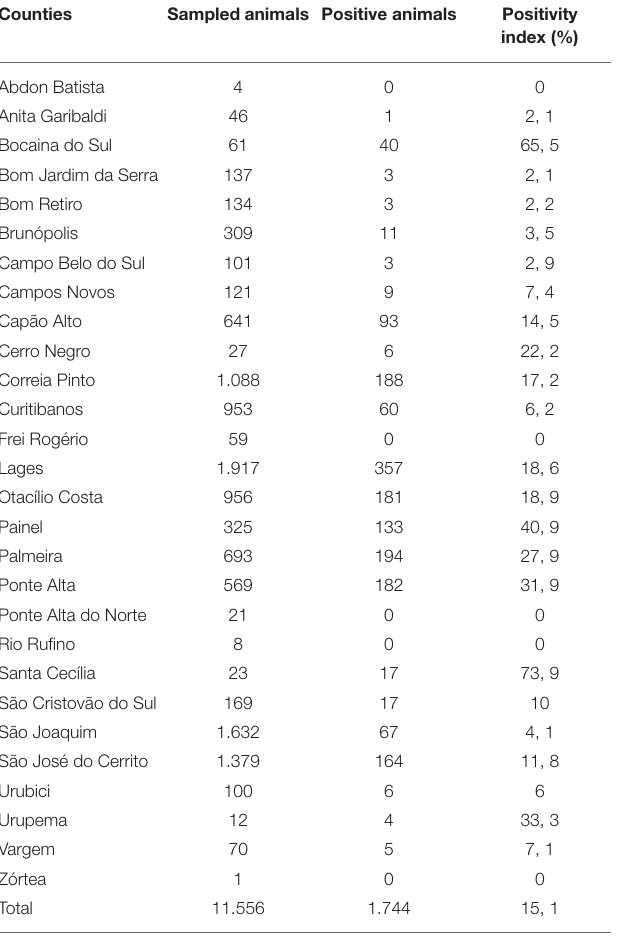
TABLE 3 | Fasciola hepatica positivity index in cattle in the slaughter line of three slaughterhouses of the State inspection system in municipalities in the Serrana Mesoregion.